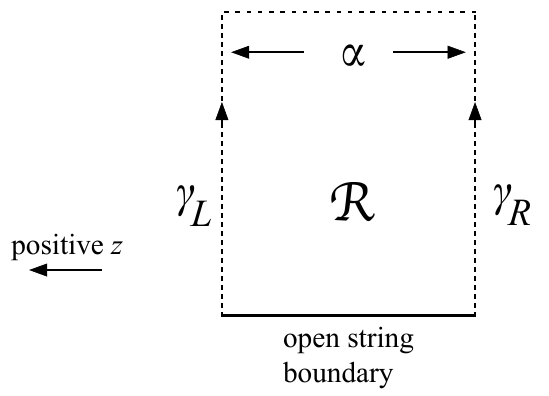
Figure 7 . The region R and the left and right parameterized curves (cid:13) L and (cid:13) R characterizing a wedge state (cid:10) (cid:11)